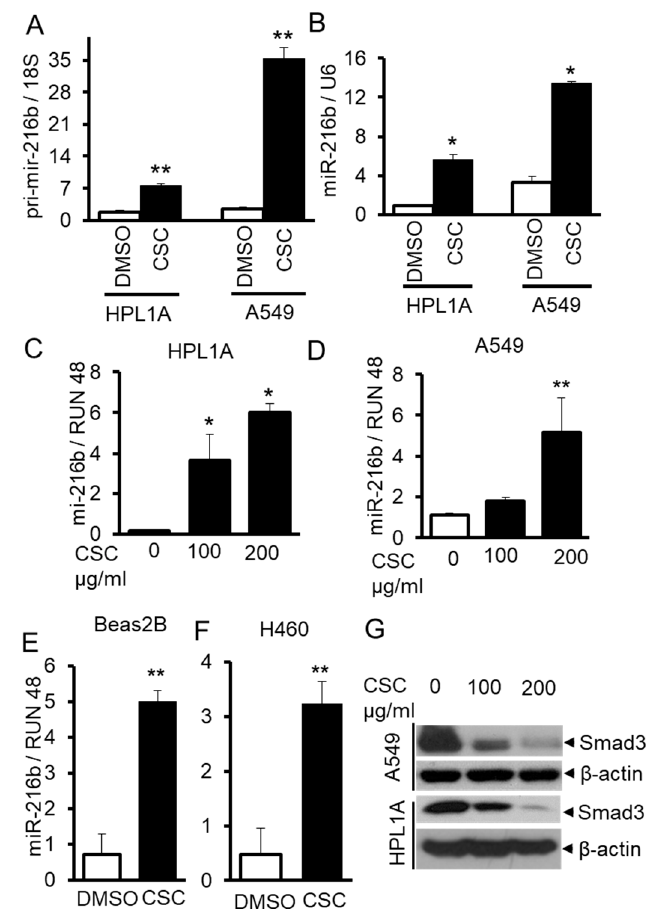
Figure 2. CSC induces miR-216b expression in human lung epithelial cells. ( A, B ) RNA was purified from HPL1A and A549 cells treated with CSC for 12 months. Pri-mir-216b and miR-216b expression levels were analyzed by real time qRT-PCR and normalized by 18S and U6, respectively ( n = 3, the mean expression and SD are displayed). An unpaired Student’s t -test was used to analyze the statistical significance of differences. * P < 0.05, ** P < 0.01 vs . DMSO group. ( C, D, E, F ) HPL1A (C), A549 (D), Beas2B (E), and H460 (F) cells were exposed to different concentrations of CSC for 6 days. MiR-216b expression was measured by real time qRT-PCR and normalized by RUN 48, * P < 0.05, ** P < 0.01. Above experiments were performed at least three times with similar results. ( G ) HPL1A and A549 cells were treated with different concentrations of CSC for 6 days. Smad3 and ß-actin expression was analyzed by Western blot analysis of the cell lysates.